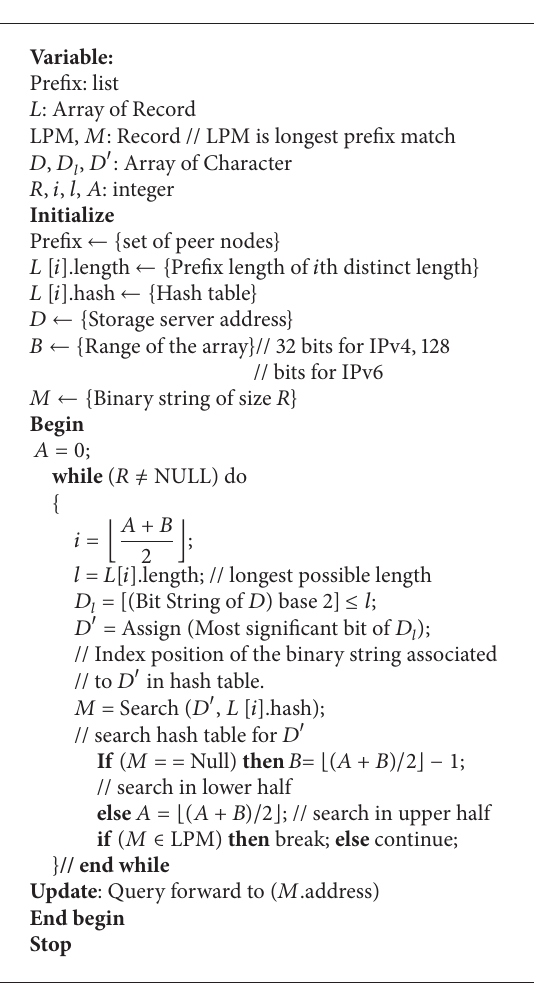
Algorithm 2: Query forward to longest prefix match